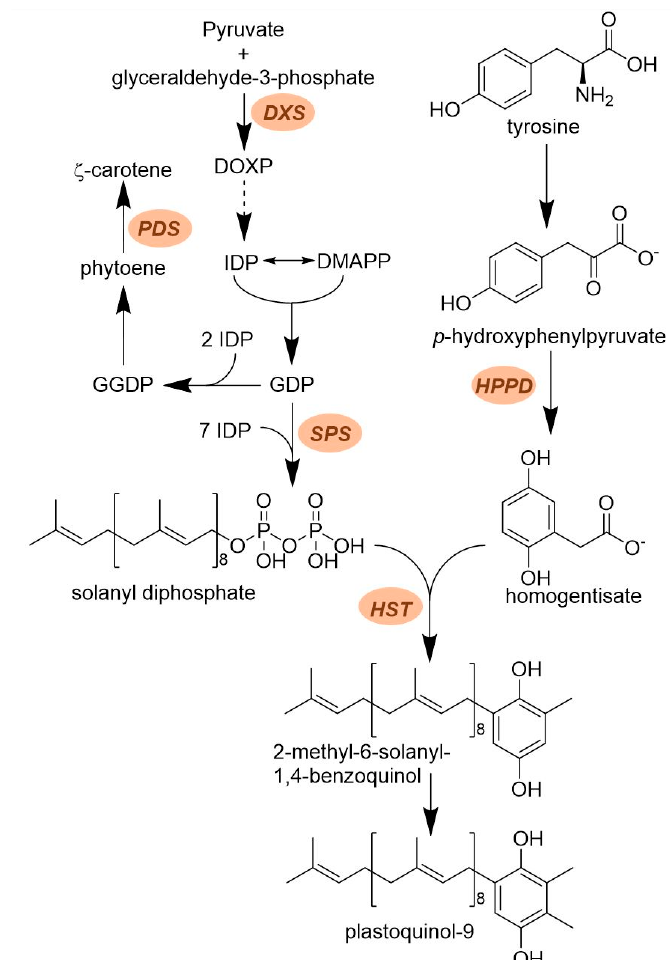
Figure 2. Overview of the relationship between carotenoid and prenyl quinone biosynthesis. Biosynthesis of carotenoids and plastoquinone requires the MEP, terpenoid and